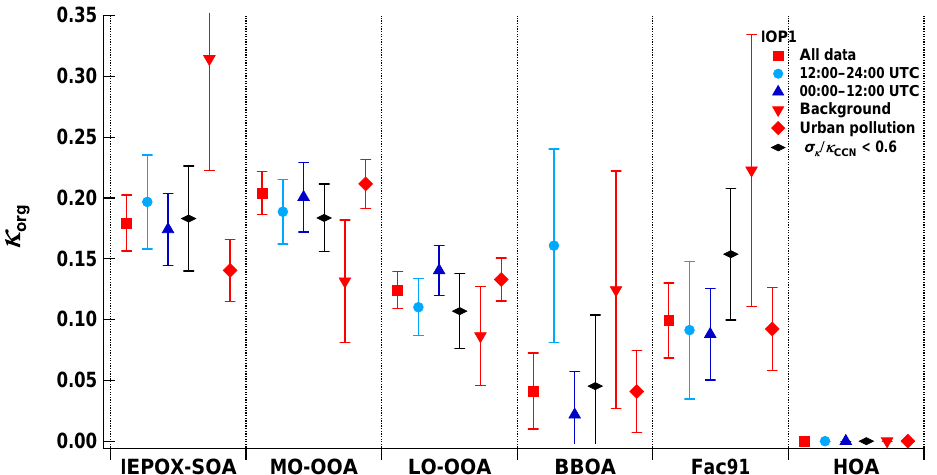
Figure 9. Hygroscopicity of AMS PMF factors for IOP1 (i.e., wet season) retrieved by multilinear regressions using all data (red square), data from UTC 12:00–24:00 (cyan circle), data from UTC 00:00–12:00 (blue triangle), data under background conditions (red triangle), data under polluted conditions (red diamond), and data with hygroscopicity dispersion σ κ